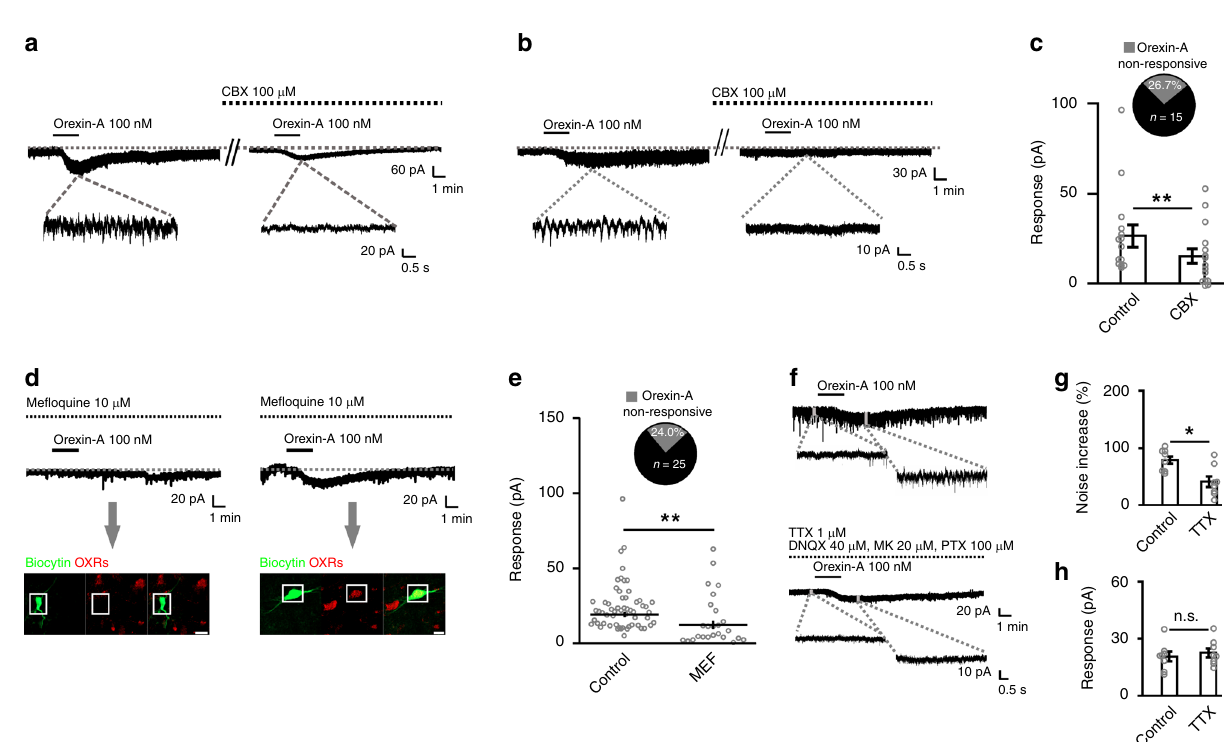
Fig. 3 The excitation of orexin in ~3/4 of SLD neurons spreads via GJs. a , b Representative traces showing that the orexin-A (100 nM) elicited inward currents were partially blocked by CBX (100 μ M) in a rat SLD neuron ( a ) and completely abolished by CBX in another ( b ). Note that the spikelet currents meditated by GJs were all blocked by CBX. c The orexin-elicited inward current was reduced in the presence of CBX in rat SLD neurons ( n = 15, two-sided Wilcoxon signed-rank test; z = 2.953, P = 3.143 × 10 − 3 ). Pie charts showing that the orexin-elicited inward current was completely abolished in 4 of 15 (26.7%) tested neurons. d Biocytin (green)-based post hoc immunostaining showed that an orexin-A non-responsive neuron from the rat SLD (left) in the presence of me fl oquine (MEF) did not express OXRs (red), and another orexin-A-responsive neuron (right) from the rat SLD in the presence of